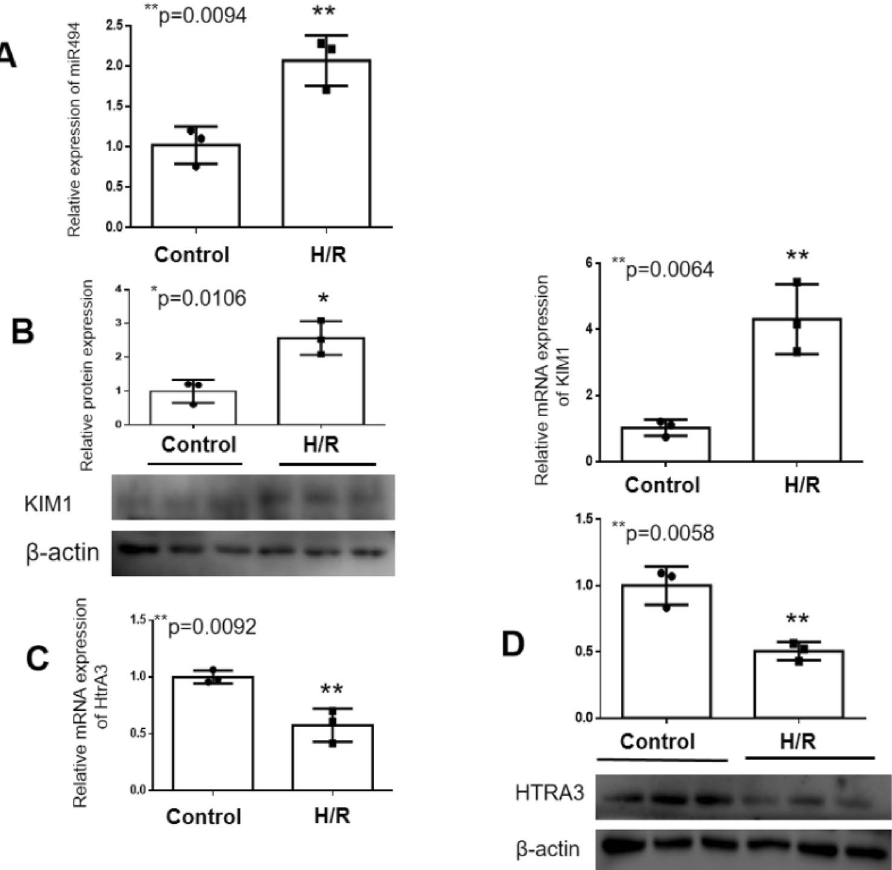
Figure 2. Effect of hsa-miR-494-3p on HK2 cells with or without hypoxia/reoxygenation. ( A ) Real-time PCR data show hypoxia/reoxygenation increased the expression of hsa-miR-494-3p; ( B ) Real-time PCR and Western blot data show hypoxia/reoxygenation increased the expression of KIM-1; ( C ) Real-time PCR data show hypoxia/reoxygenation decreased mRNA levels of HtrA3; ( D ) Western blot data show a lower expression of HtrA3 in the hypoxia-reoxygenation HK2 cells. N (the replicate for above experiments) = 3. *P < 0.05, **P < 0.01, versus